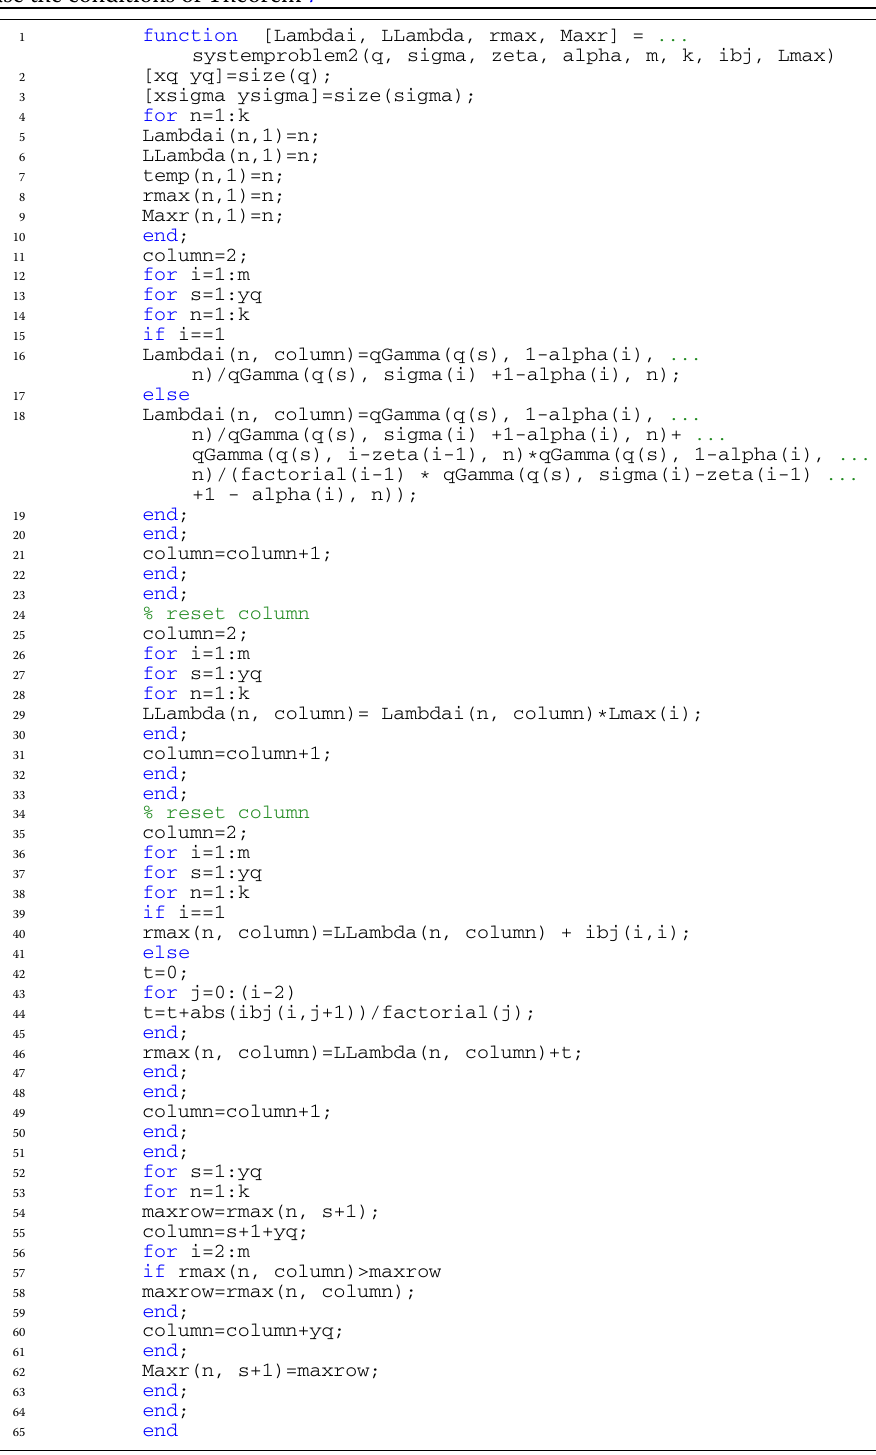
Algorithm 7 The proposed method for solving problem (29) in Example 2 for which we use the conditions of Theorem